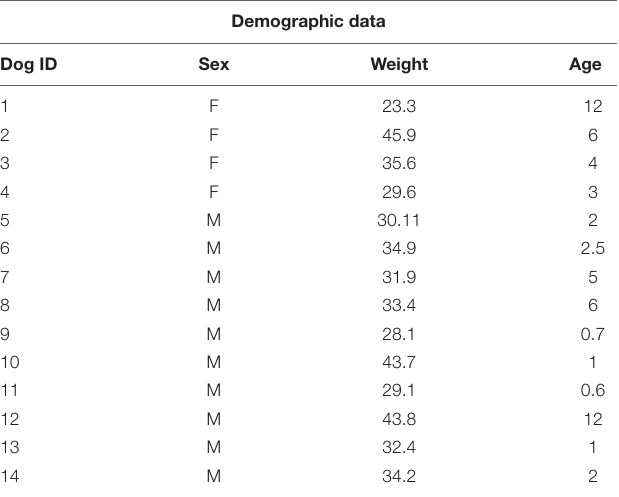
TABLE 1 | Demographic data: Sex, weight (kilograms), age (years). Demographic